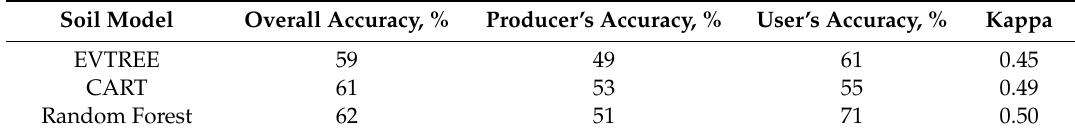
Table 6. Accuracy of the soil maps after reducing the size of the training sample set.